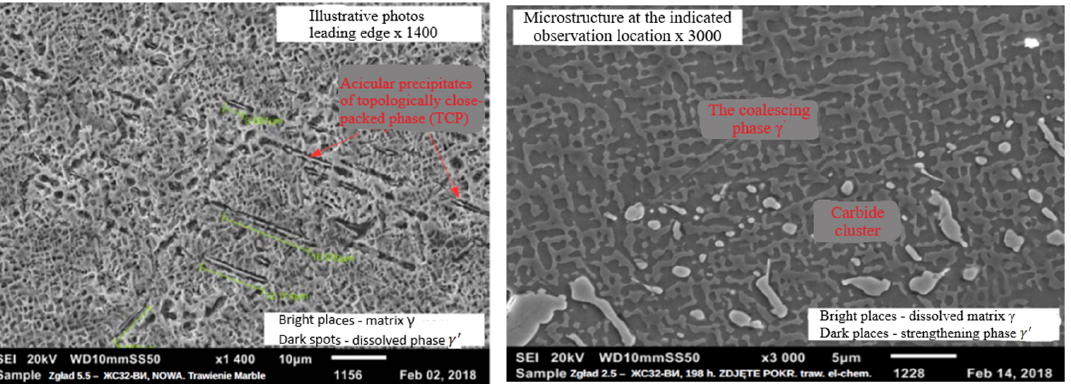
Figure 18. The microstructure of the blade material on its leading edge covered with a protective coating of the APS + SLURRY type.